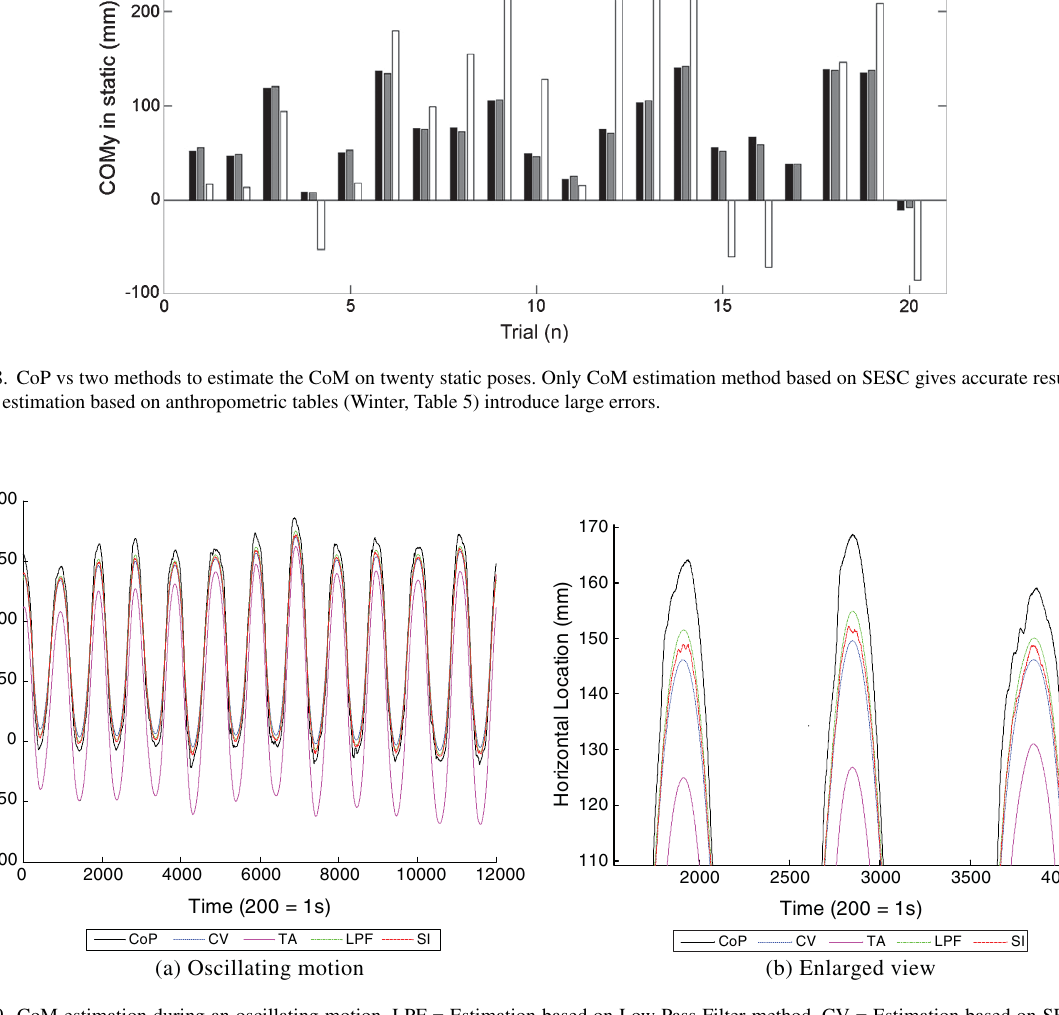
Fig. 9. CoM estimation during an oscillating motion. LPF = Estimation based on Low Pass Filter method. CV = Estimation based on SESC method. TA = Estimation based on anthropometric tables. SI = Estimation based on Second Integral